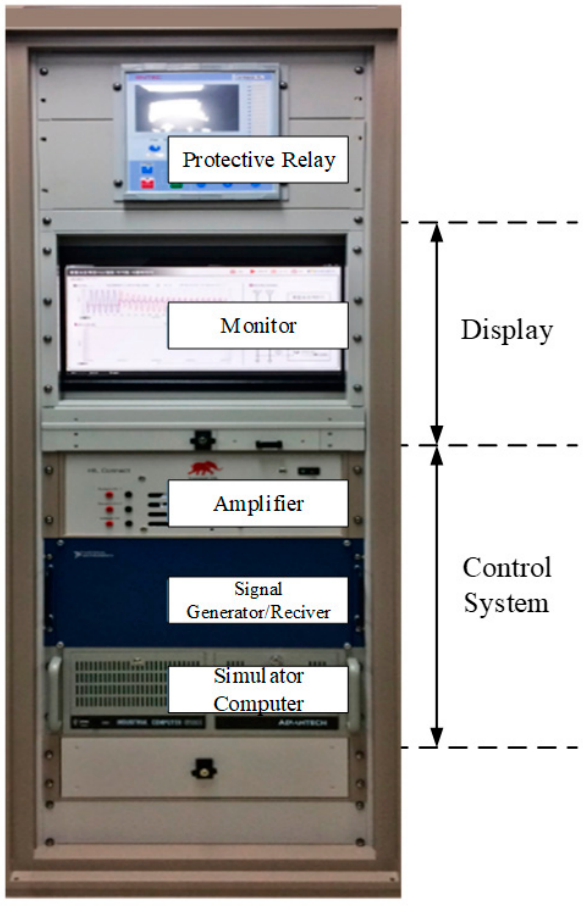
Figure 5. The fabricated PREDIS-R.